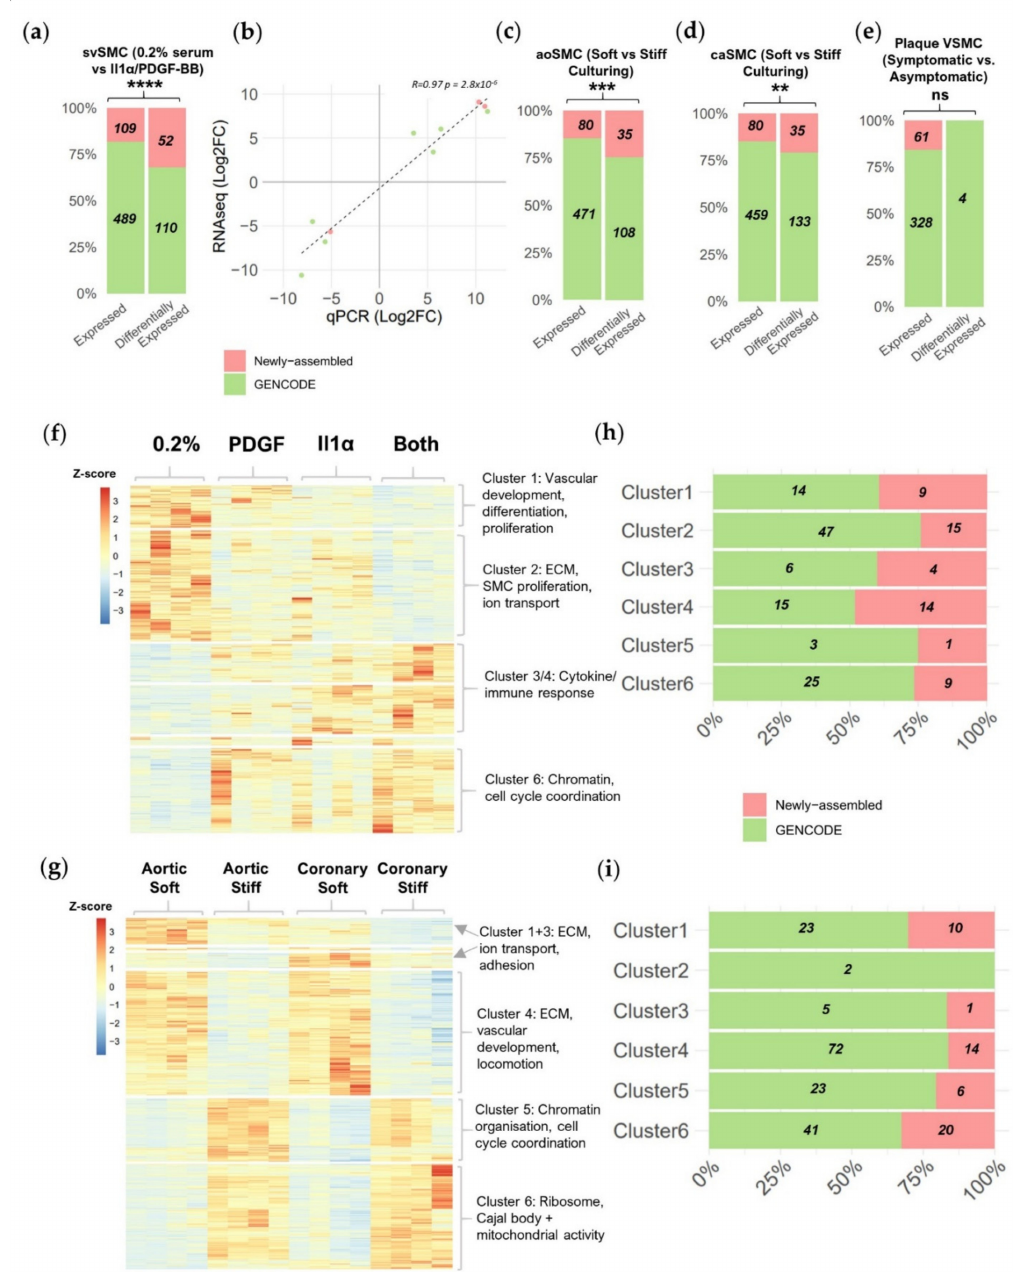
Figure 2. Newly assembled lncRNAs show a tendency to respond to pro-mitogenic stimuli. ( a ) Proportion of GENCODE and newly assembled lncRNAs expressed or differentially expressed in the saphenous vein VSMC (svSMC) dataset (Fisher’s exact test, background of all expressed genes). ( b ) Validation of expression dynamics in the svSMC RNAseq dataset by qRT-PCR for six lncRNAs (Spearman’s rank, p = 6.7 × 10 − 4 ). ( c – e ) Same as ( a ) but for remaining VSMC datasets. Expression heatmap of differentially expressed genes expression responding to ( f ) interleukin-1 α (IL-1 α )/platelet-derived growth factor-BB (PDGF-BB) or ( g ) stiff-culturing clustered hierarchically based on their variation across all samples with selected over-represented gene ontologies derived for each cluster. Proportion of GENCODE and newly assembled lncRNAs in each cluster of differentially expressed genes responding to ( h ) IL-1 α /PDGF or ( i ) stiff-culturing. ( a , c – e ) p < 0.0001 ****, p < 0.001 ***, p < 0.01 **, ns not